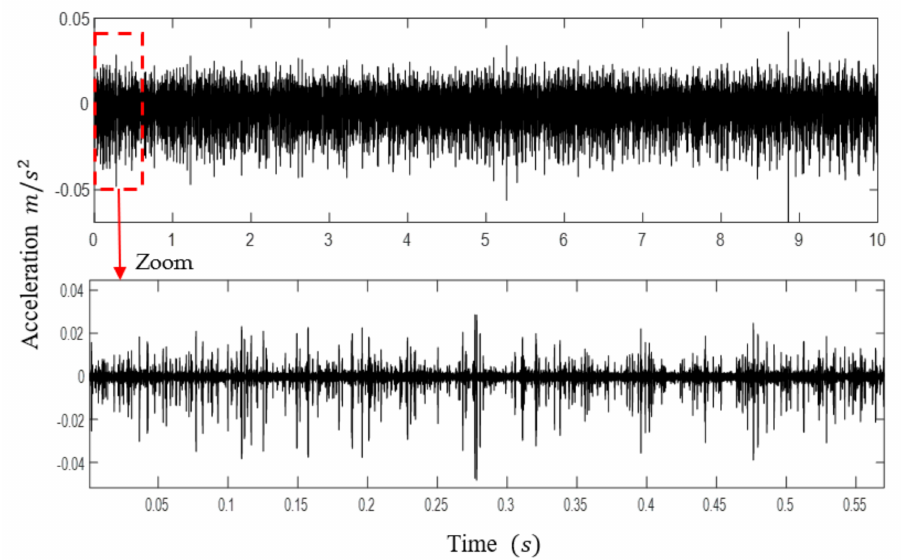
Figure 5. Filtered vibration signal of the faulty